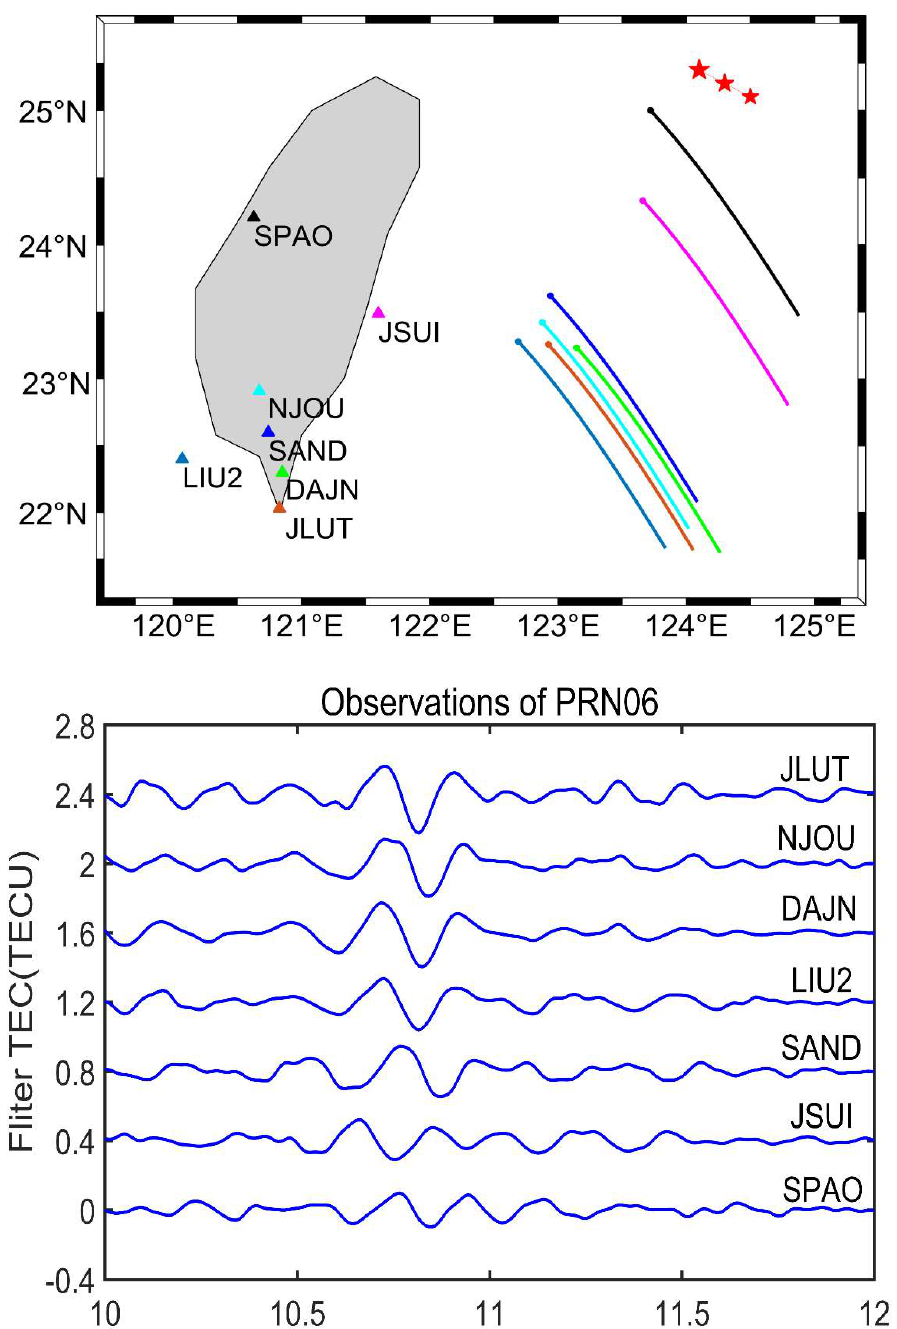
Figure 6. The tracks of SIP at seven selected stations in the up panel and filtered TEC time series changes at selected stations in the bottom panel when the typhoon passed through the eastern sea area of Taiwan on July 10, 2018.